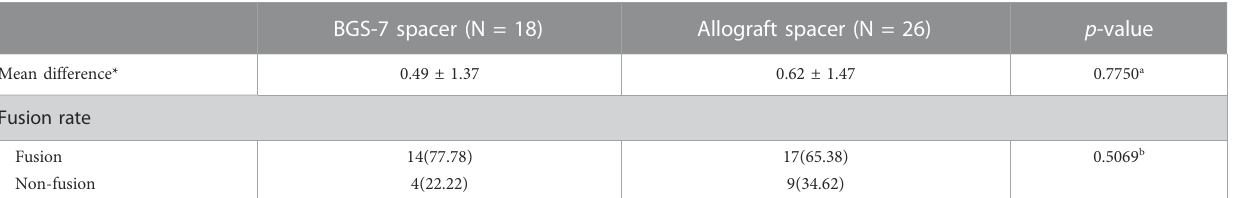
TABLE 6 Evaluation of fusion based on dynamic stability ( ≥ 60M).